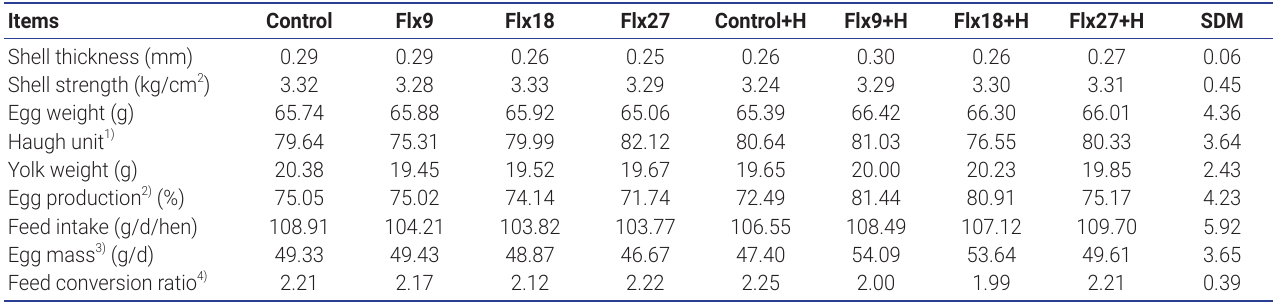
Table 4. Egg performance of laying hen fed test diets with different levels of extruded flaxseed with and without herbal medicine for nine